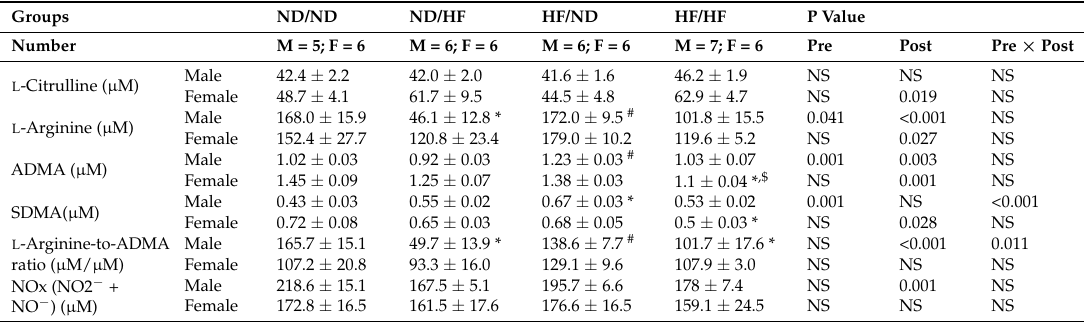
Table 4. Plasma levels of L -arginine, L -citrulline, ADMA, SDMA, and NO in offspring at six months of age.